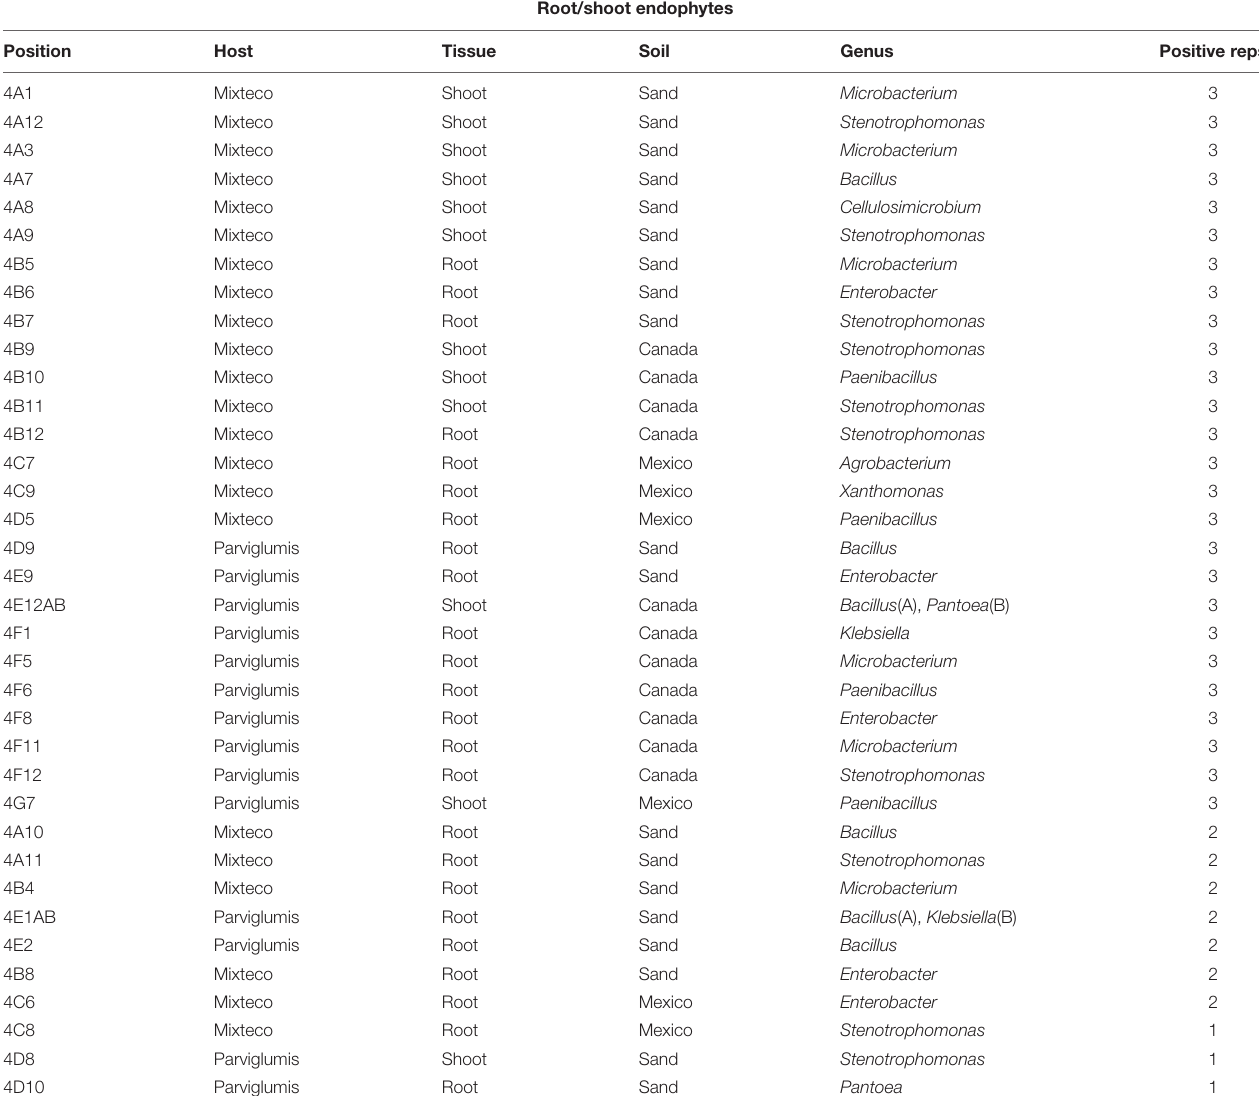
TABLE 2 | Summary of maize endophytes that secrete Gln in vitro on nitrogen-free Burk’s GlnLux